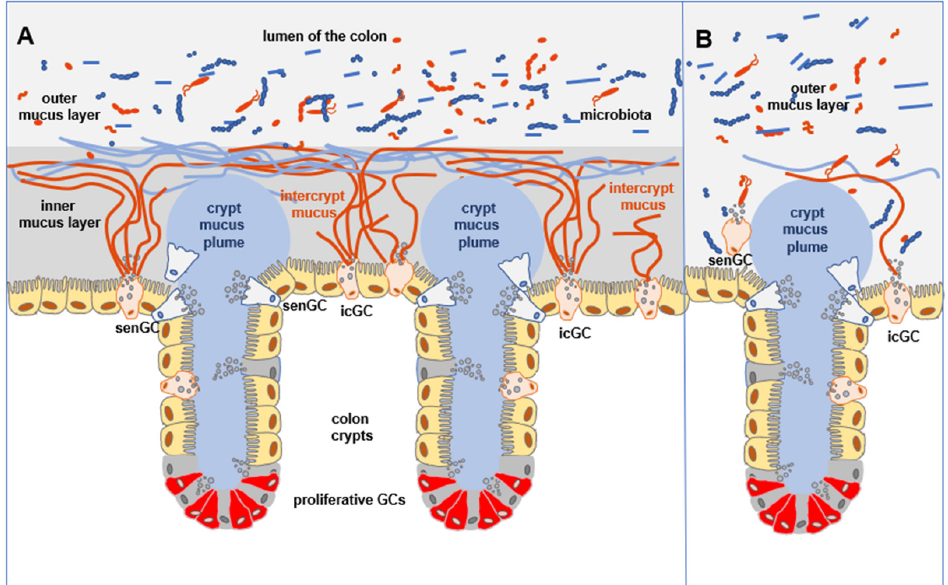
Figure 2. A representative schematic of colon crypts (according to [32]). ( A ) Colonocytes are the most numerous epithelial cell population of the colon. Constantly dividing stem cells differentiate into proliferative goblet cells that give rise to diverse populations of goblet cells that participate in the formation of mucus barrier, due to secretion of MUC2. The colon mucus barrier is formed of the inner mucus layer, free of microbiota and outer mucus layer, penetrable for microorganisms. Thick crypt mucus plumes, impermeable for bacteria, shield stem cells area, are secreted by crypt goblet cells among which, at the entrance to the crypt are located sentinel goblet cells (senGCs). Upon TLR ligand stimulation, senGCs form NLRP6 inflammasome, and the production of reactive oxygen species occurs. This will lead to the release of Ca 2+ that passed through gap junctions to neighboring cells, inducing mucus release. Activated senGCs are expelled to the lumen. Between crypts lie highly differentiated intercrypt goblet cells (inGCs), secreting intercrypt mucus, penetrable for small molecules. Intercrypt mucus and crypt mucus plume form the colon inner mucus layer. Together, populations of goblet cells form a network that protects epithelium against microbial colonization. Any disruption of inGCs results in epithelial exposure to bacteria and the possible development of colitis. ( B ) The diminished number of inGCs due to the increased cell shedding to the lumen results in altering the mucus barrier in the colon. The only outer mucus layer is present, which is penetrable for microorganisms, which can contribute to colitis